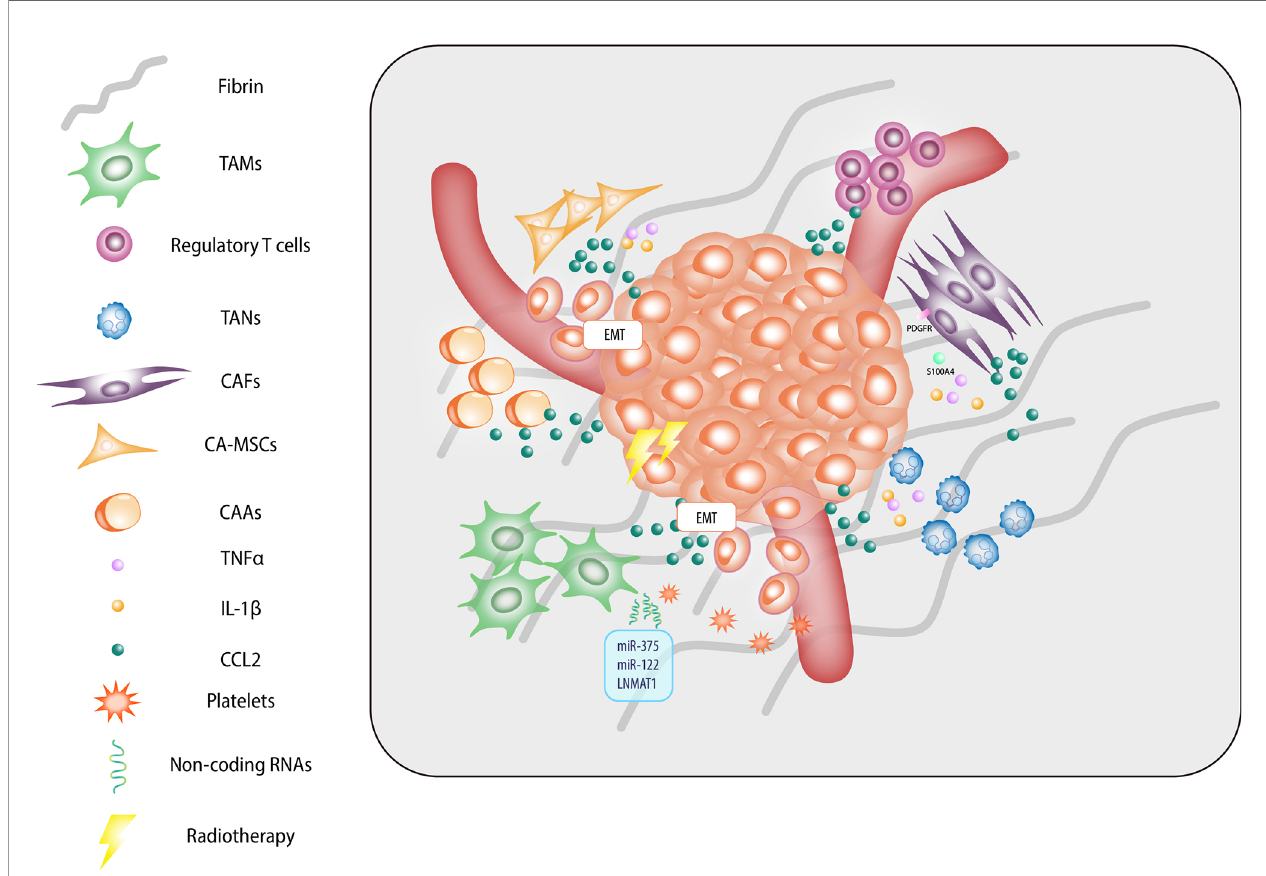
FIGURE 2 | Host cells are involved in the tumor